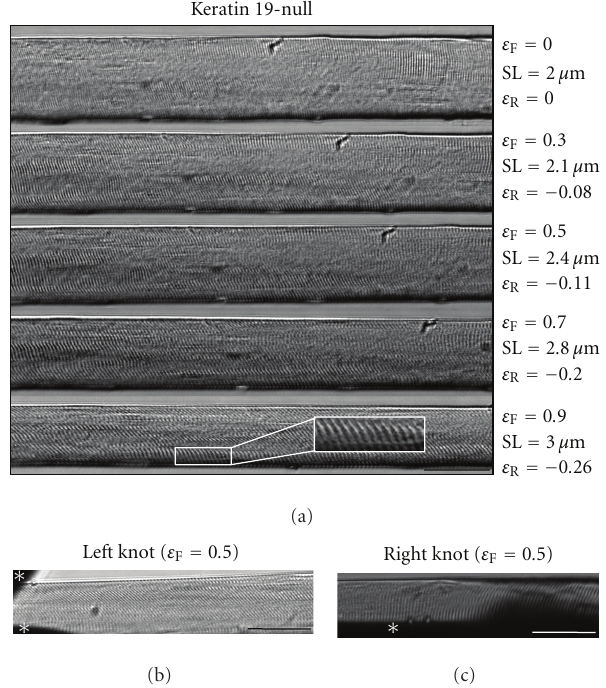
Figure 6: Geometric and structural response of a 10-month-old K19-null fiber to tensile loading. (a) The same region of the fiber, imaged using phase-contrast microscopy, is shown at five di ff erent deformations. Fiber strains, radial strains, and sarcomere lengths are reported to the right of the fiber for each deformation. The fiber displays aligned Z-lines, but discontinuity between fiber deformation and sarcomere strain. This fiber also displays considerable shear, as seen by the slanting of Z-lines (dark lines). A sample region of the fiber that displays particularly well aligned Z-lines that are experiencing some shear is marked with a white box. The boxed region has been computationally enlarged 2x for clarity. There is no slippage or damage of the fiber at the (b) left edge or (c) right edge, imaged in the vicinity of the knot and pins (starred black regions in the periphery of the image) at a moderate fiber strain of 0.5. This may be concluded from the gradual reduction in of the slant of Z-disks away from the knot, which is located to the left in (b) and to the right in (c). Bar = 50 μ m.